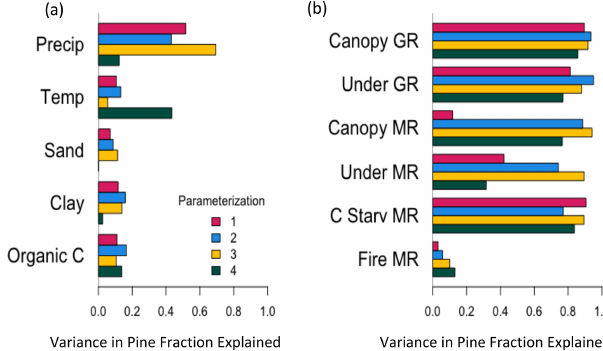
Figure 7. Variance in the fraction of pine basal area relative to the total basal area of pine and incense cedar that is explained by envi- ronmental variables (a) and the difference between pine and incense cedar (pine minus cedar) growth (GR) and mortality rates (MR; b ) for each of four pine and cedar parameterizations over a regional do- main in the Sierra Nevada mixed-conifer forest, starting from bare ground and run with fire active for 100 years. Pine fraction was cal- culated for the final year and rates were averaged over the duration of the FATES